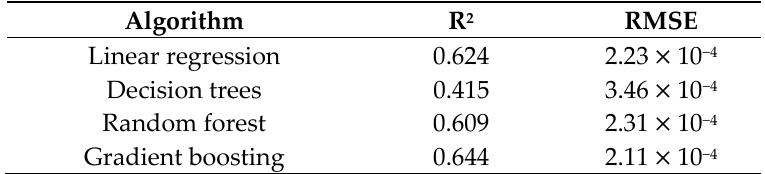
Figure 4. Comparison between true value and prediction of groundwater level based on gradient boosting. Groundwater level has been calculated with the sum of all the changes from the beginning of prediction. Table 1. Modeling results of groundwater level change prediction, based on weather data. 4 different algorithms were used. Each method has been run on a dataset of 5 different nodes from Ljubljana polje